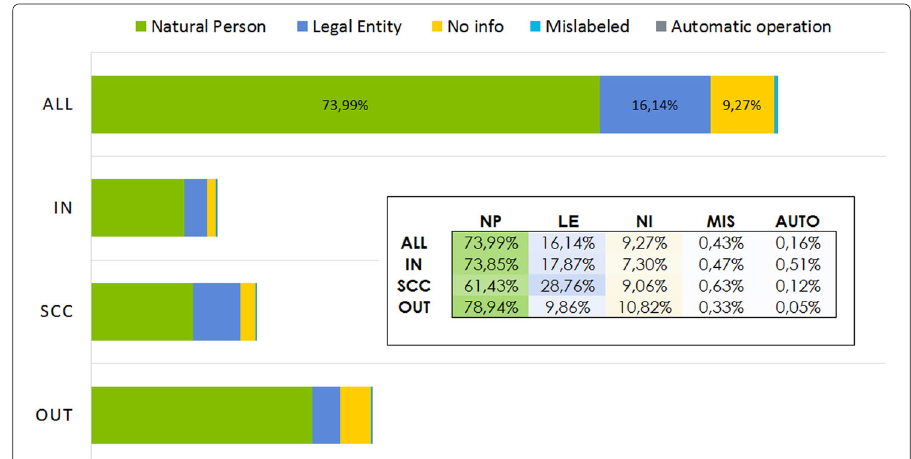
Fig. 12 Node type distribution in different bow-tie components: the length of the bars represents the size of the components respect to the whole network (ALL). Please note that a small percentage of accounts are labelled “No Info” because owners did not authorise analysis of their data; moreover, a very small portion of